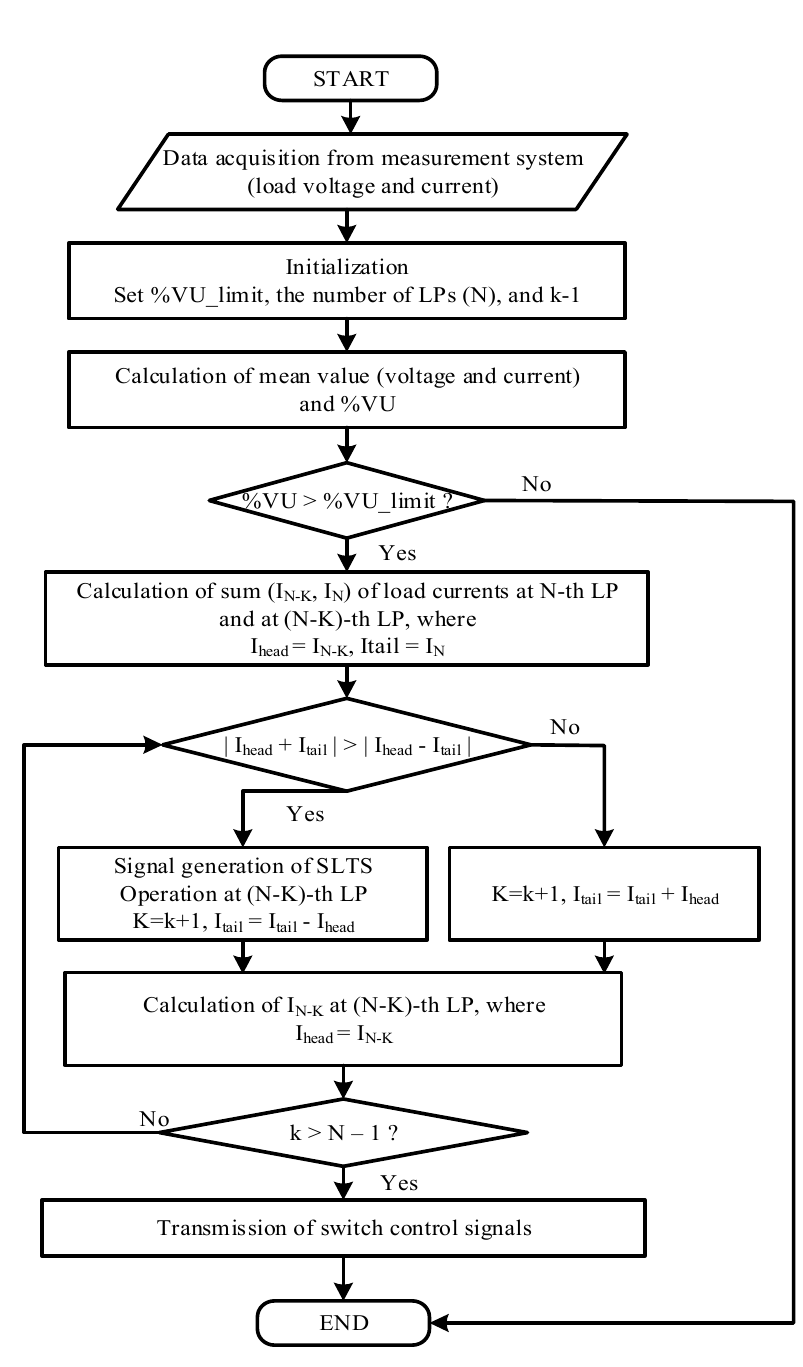
Figure 13. Flowchart of proposed SLTS method [20].